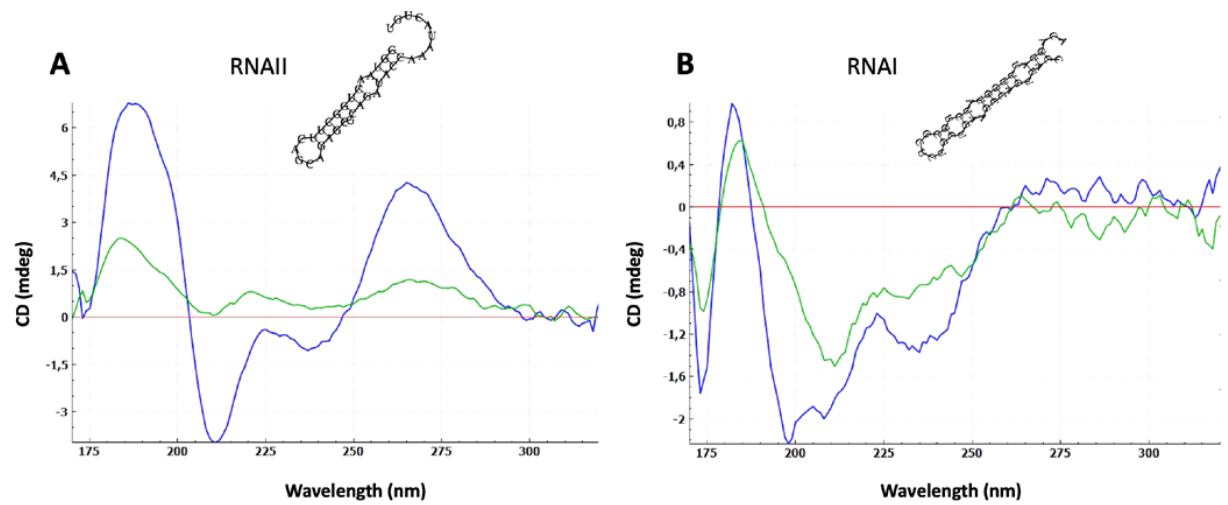
Figure 9. Observation of RNA II structure stabilization by Hfq-CTR using SRCD ( A ), while for RNA I, the CTR does not have a significant effect ( B ). Spectra in blue are with Hfq-CTR; those in green are without Hfq-CTR. The stabilization is observed by the increased amplitudes at ~185 and 270 nm. Around 270 nm, the CD signal shows base-pairing and base-stacking [42], while the positive band at 185 nm together with the negative band around 200 nm are indicative for the formation of RNA double-stranded right-handed helix [50]. Secondary structures of RNAs corresponding to relevant spectra are also shown.